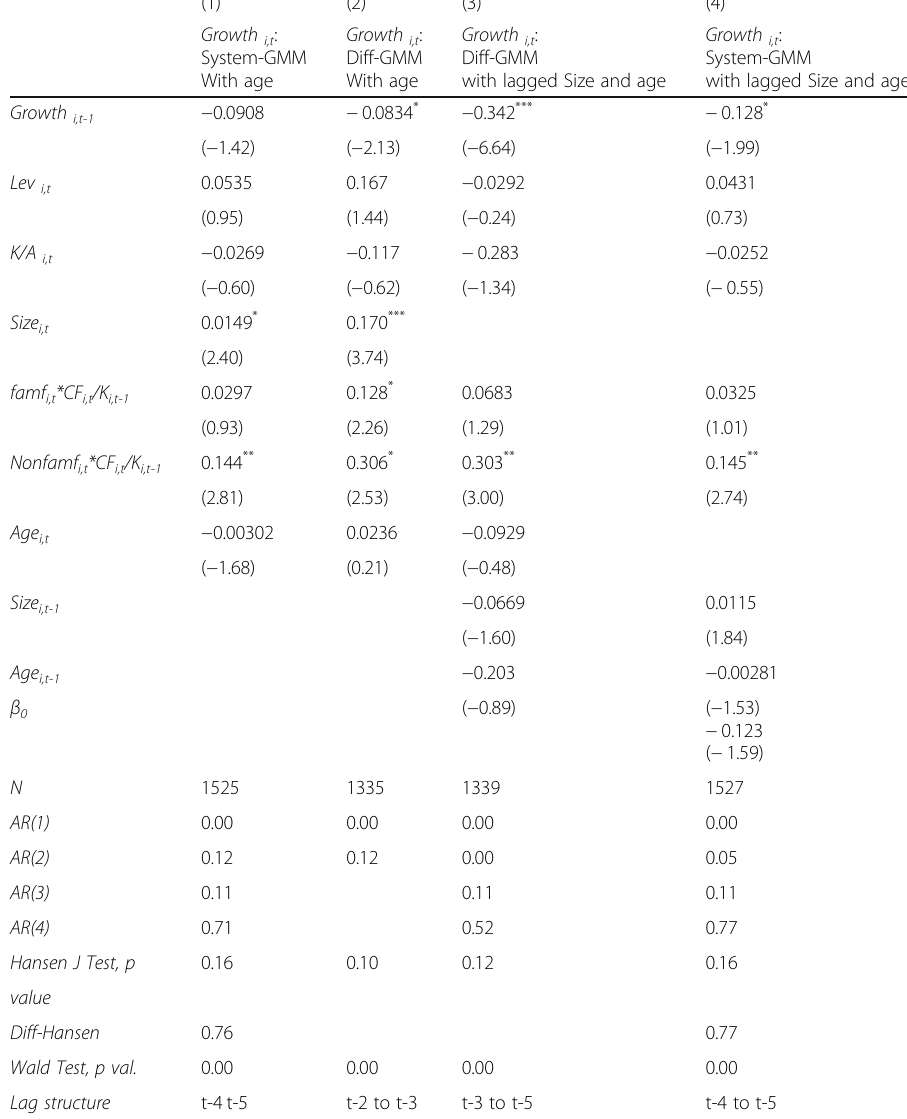
Table 10 The estimated models with Age and